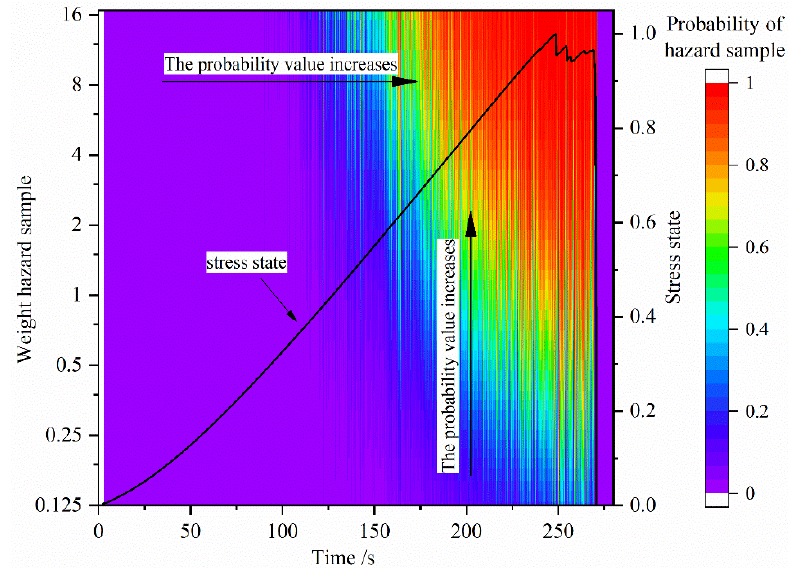
Figure 15. Cloud chart of the probability value of AIEFPC with different category weights of haz- ardous sample on the test set aD8-5 samples at different time.